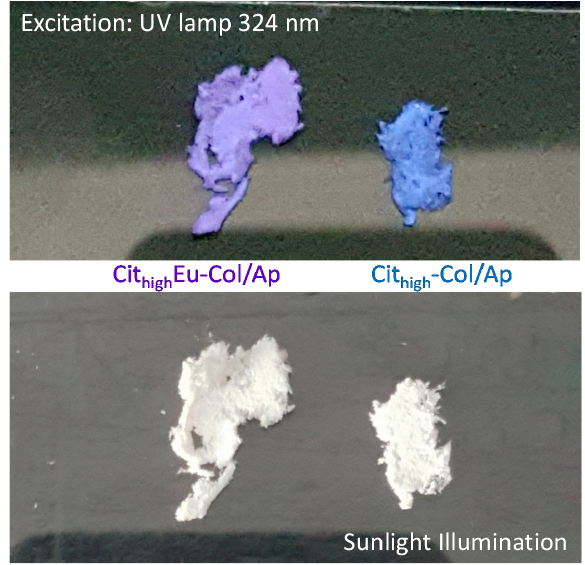
Figure 5. Picture of Cit high Eu – Col/Ap ( left ) and Cit high – Col/Ap ( right ) under sunlight (down) and 324 nm UV – lamp illumination (up).